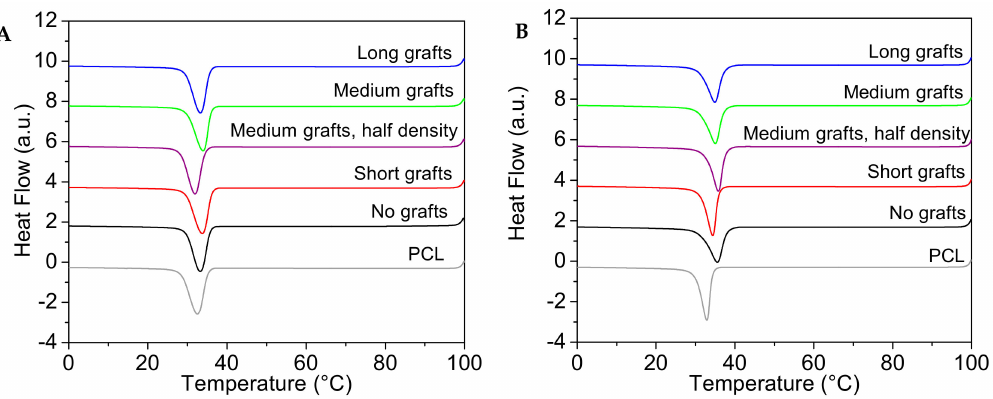
Figure 6. DSC cooling traces for PCL / silica composites based on PCL40 matrix and 1 wt% filler ( A ) PCL / silica composites based on PCL80 matrix and 1 wt% filler ( B